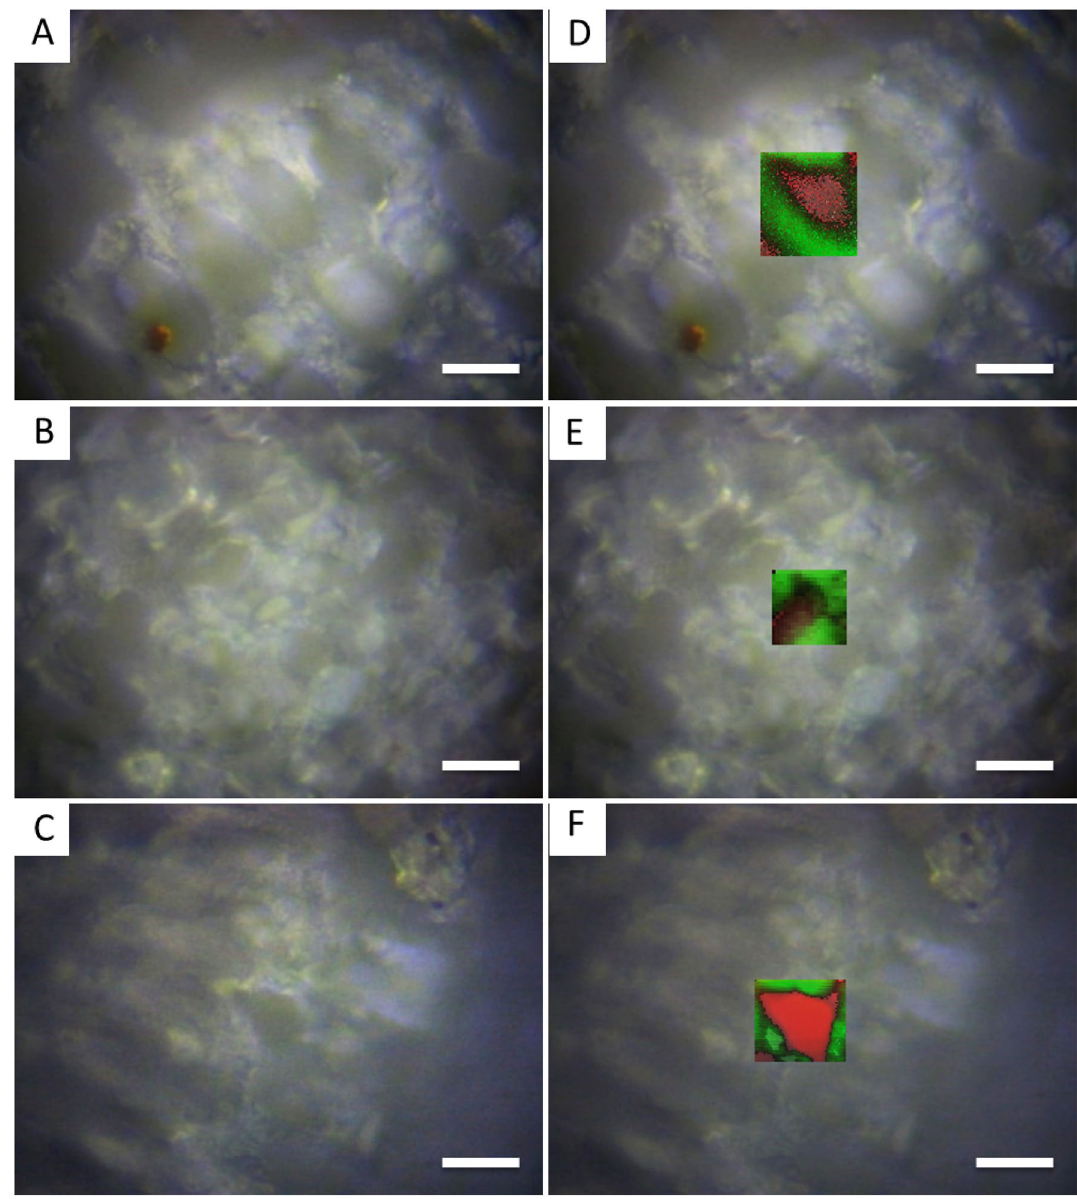
Figure 1. Bright field optical microscopy of the three samples from the three different families of the order Corallinales (Corallinaceae ( A) ; Hapalidiaceae ( B) ; and Sporolithaceae ( C) ). Bright field image overlaid Raman mapping indicates the same pattern from the three samples, with high-Mg calcite in the internal cell walls and aragonite as a “shell” close to the cell membrane (green: high-Mg calcite; red: aragonite). Scale bars: 20